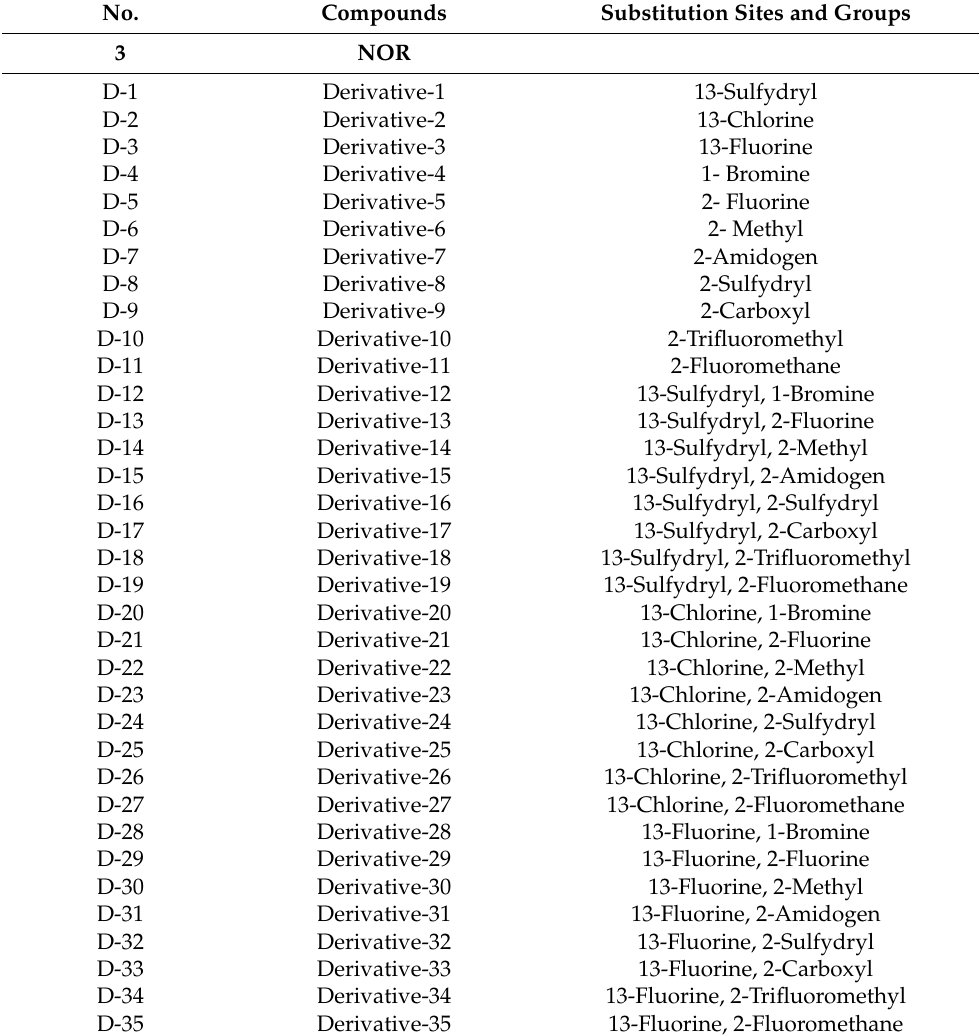
Table 3. Substitution sites and groups in